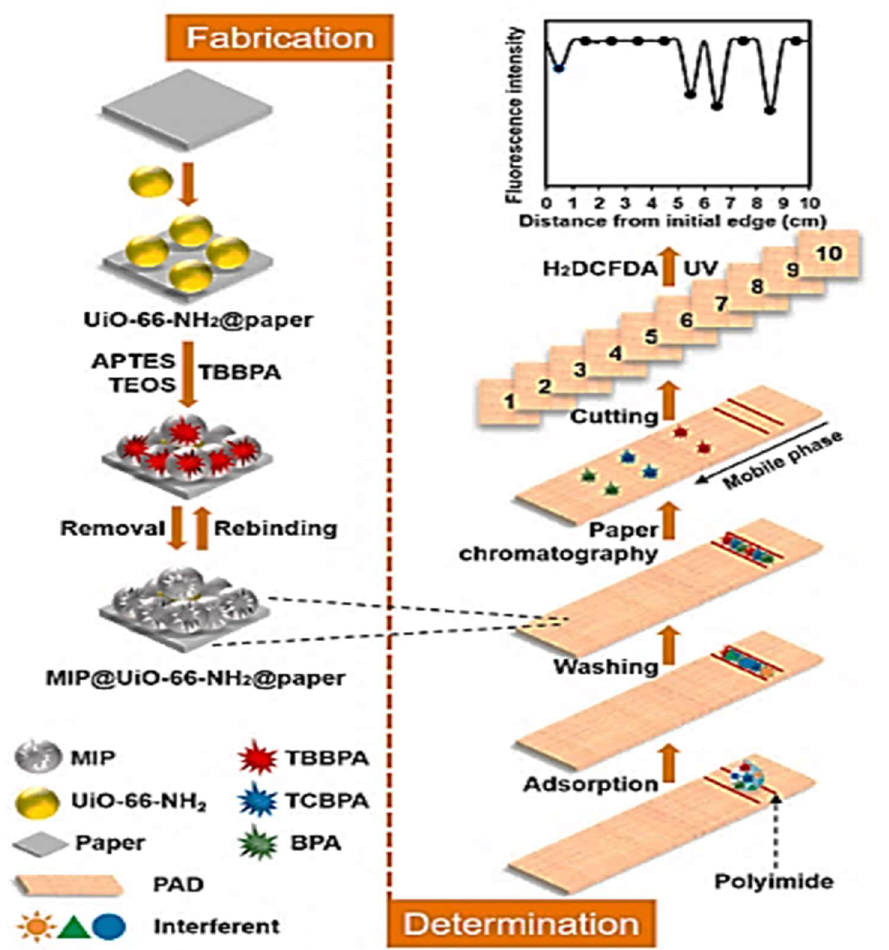
Figure 11. Schematic illustration for the preparation of MIP@ photocatalyst of UiO-66-NH 2 @paper and associated analysis procedures on paper-based analytical device (PAD) for the detection of Tetrabromobisphenol A (TBBPA) and tetrachlorobisphenol A (TCBPA). (Reproduced under permission from Elsevier, doi:10.1016/j.bios.2021.113106).